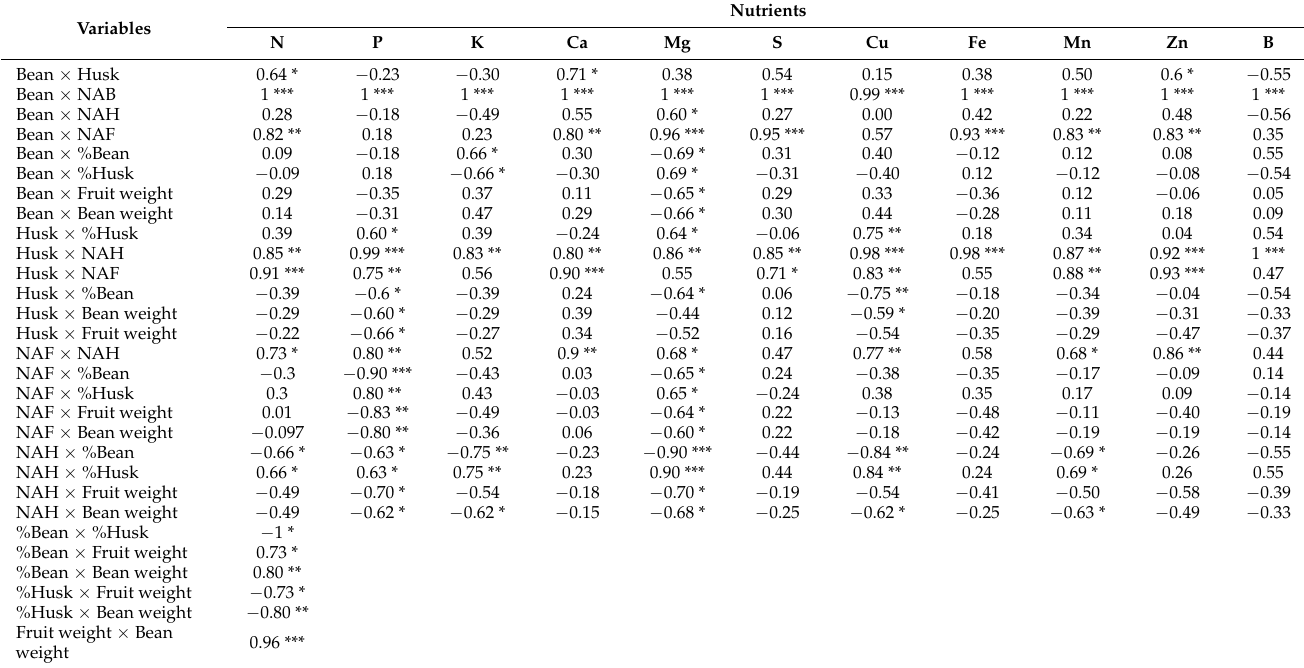
Table 7. Spearman correlation matrix between nutrient accumulation in bean, husk, fruit, husk percentage, bean percentage, fruit weight, and bean weight in nine Coffea arabica cultivars, grown in the Gorongosa Mountain region, Gorongosa National Park, Sofala,